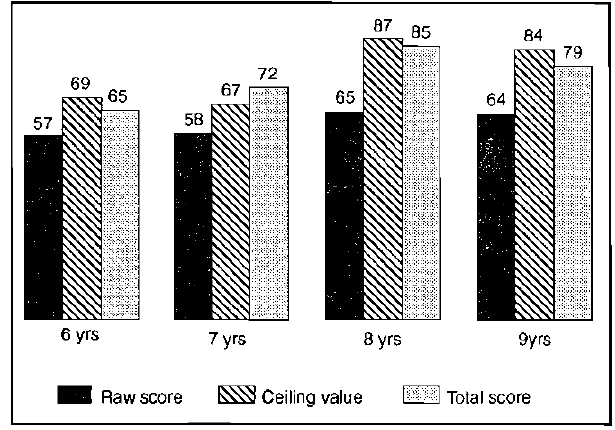
FIGURE 1: Mean raw scores, ceiling values and to- tal scores obtained by each age group Statistical analysis of the data, which is visually rep- resented in the above bar chart, indicates a significant increase in raw scores as well as in ceiling values, in con- junction with an increase in age, between the seven and eight year old pupils only. The differences between the six and seven year old groups, and the eight and nine year old groups were not of a statistically significant